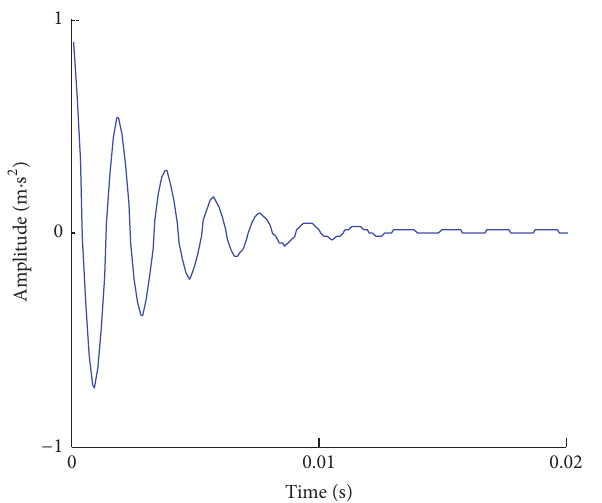
Figure 3: The waveform of the modulation frequencies.